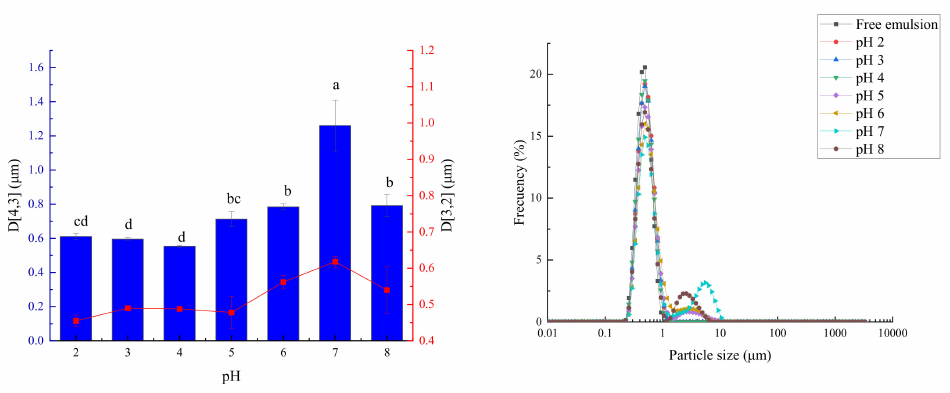
Figure 9. The change of emulsion particle size under different pH ( left ) and the particle size distribu- tion diagram ( right ). Note: Different letters represent significant differences ( p <